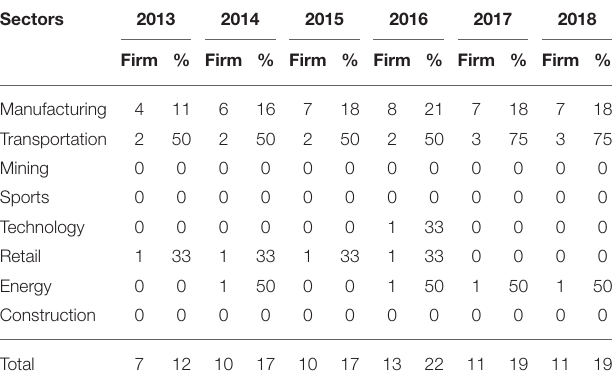
TABLE 7 | Distribution of option contracts by